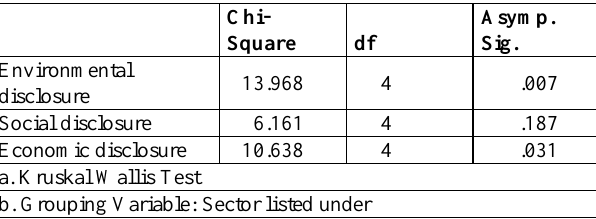
Table 4B: Test statistics a,b